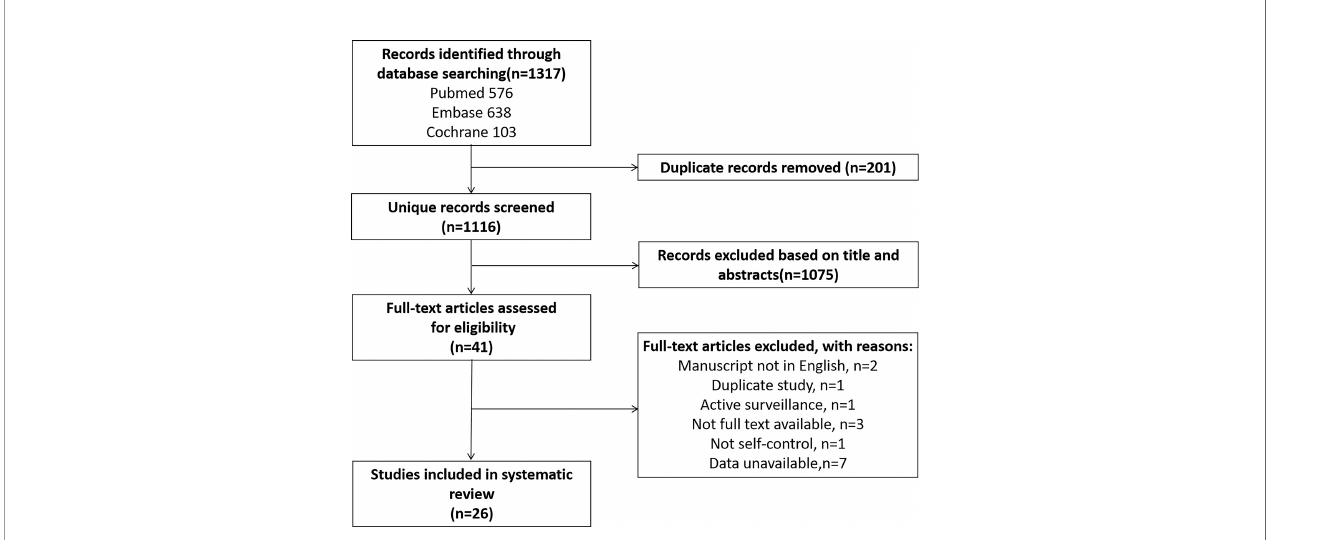
FIGURE 1 | Flowchart of the search